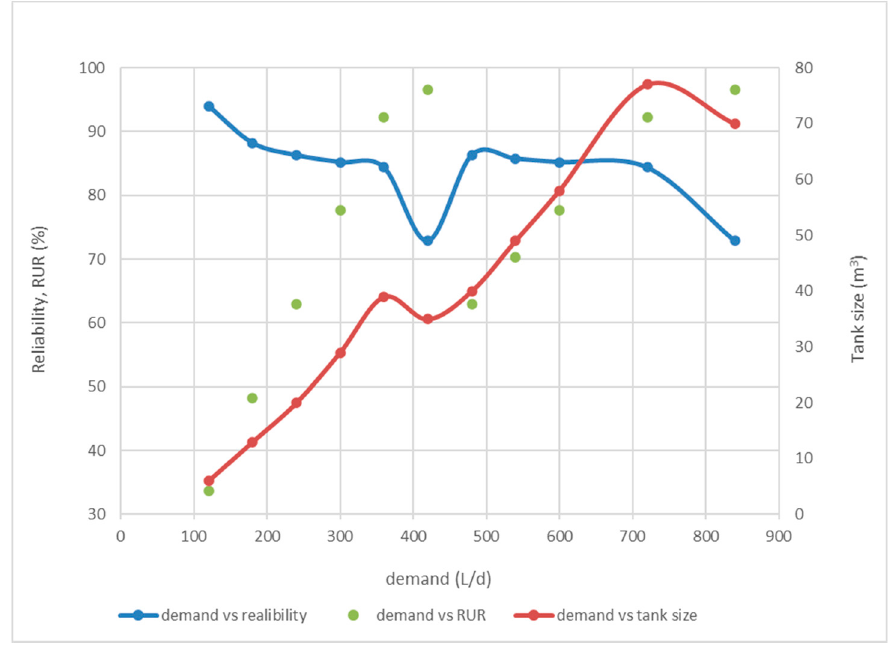
Figure 3. Effects of individual demand variations on harvested rainwater storage and reliability.